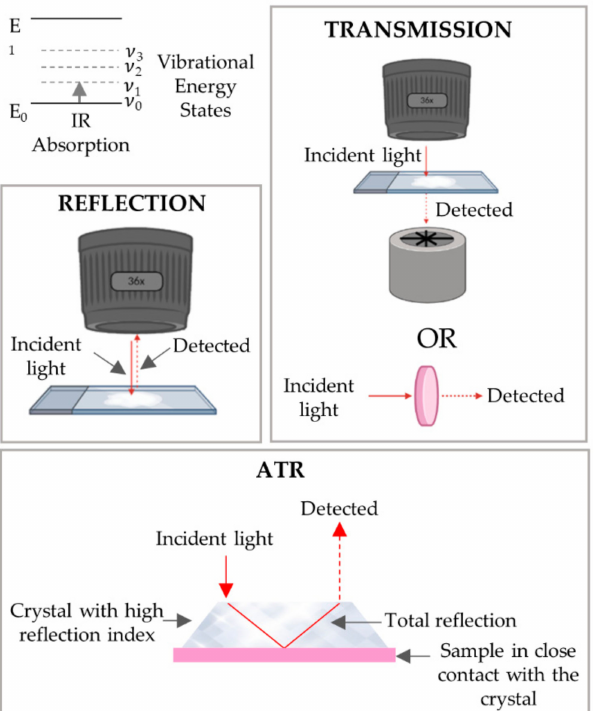
Figure 9. Schematic representation of the energetic transition occurred during infrared absorption and FTIR modes of acquisition: transmission, reflection and